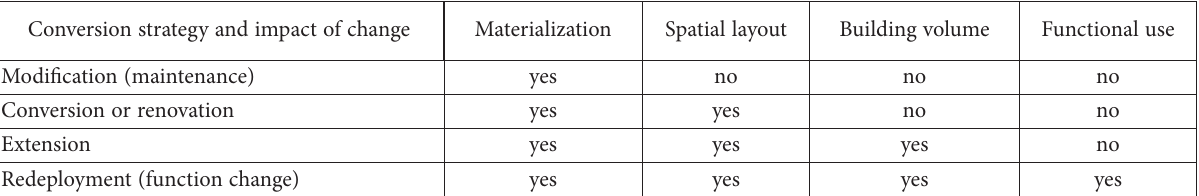
Table 3. Overview of the differences between the four general conversion strategies (source: Den Heijer et al., 2013) Conversion strategy and impact of